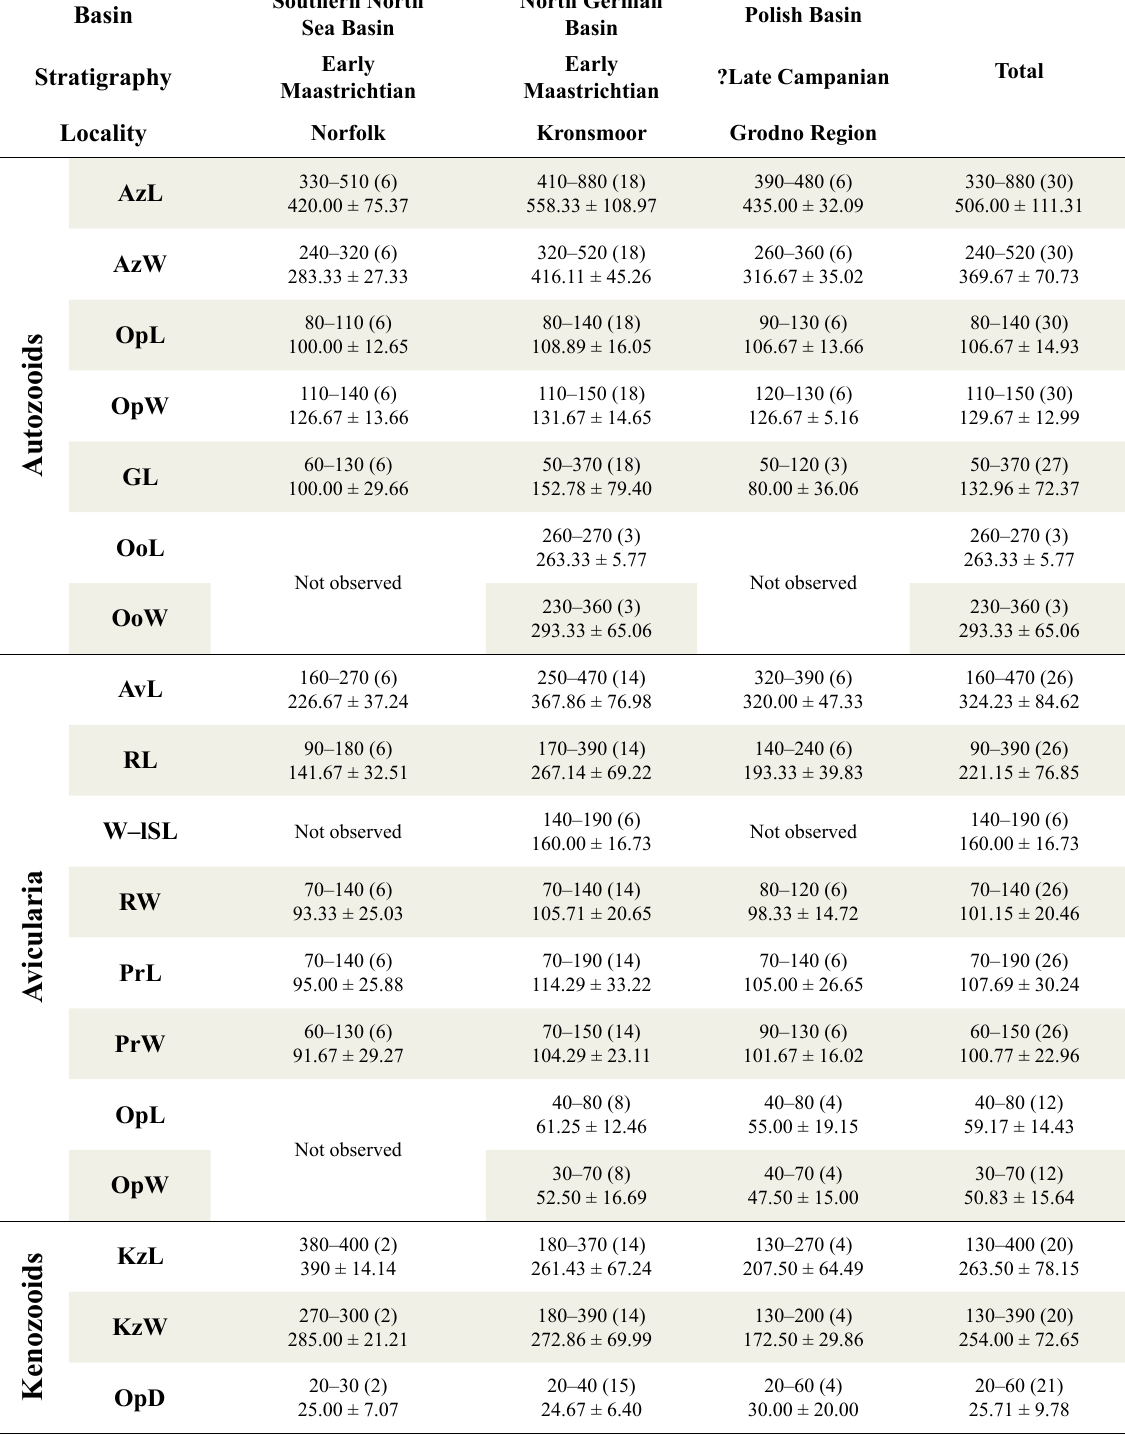
Table 8. Summary of measurements of Rhagasostoma gibbosulum Brydone, 1936. For each parameter the range is given with the number of measurements in brackets. The arithmetic mean is given ± standard deviation. All measurements in